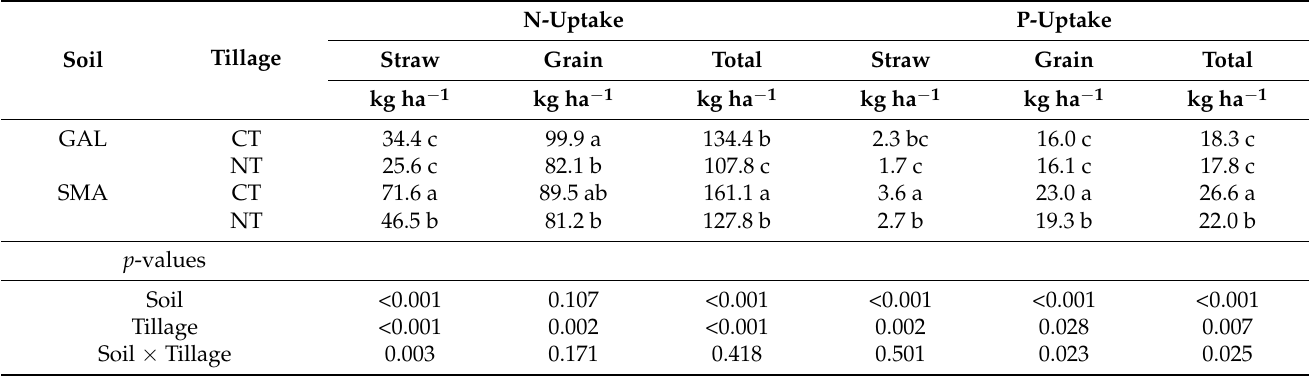
Table 2. Effect of soil (GAL and SMA), tillage system (CT and NT), and their interaction on wheat straw, grain, and total N and P uptakes. Reported values are means ( n = 4). Different letters